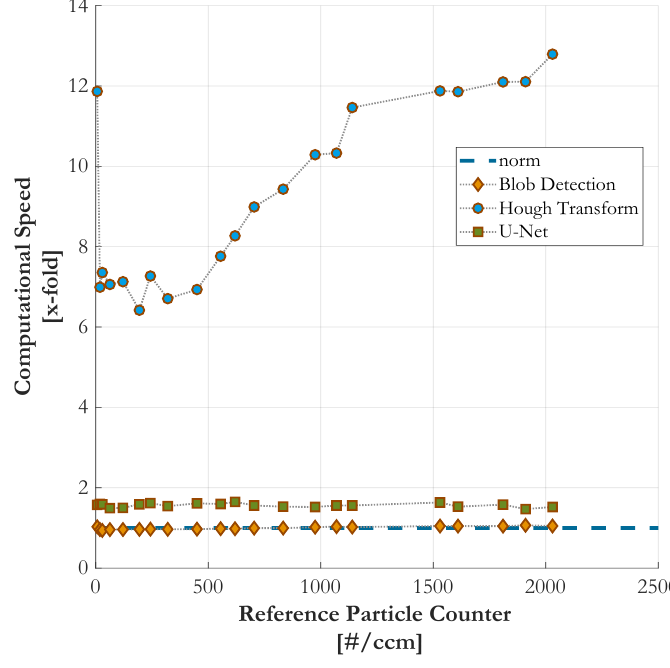
Figure 9. Comparison of computational